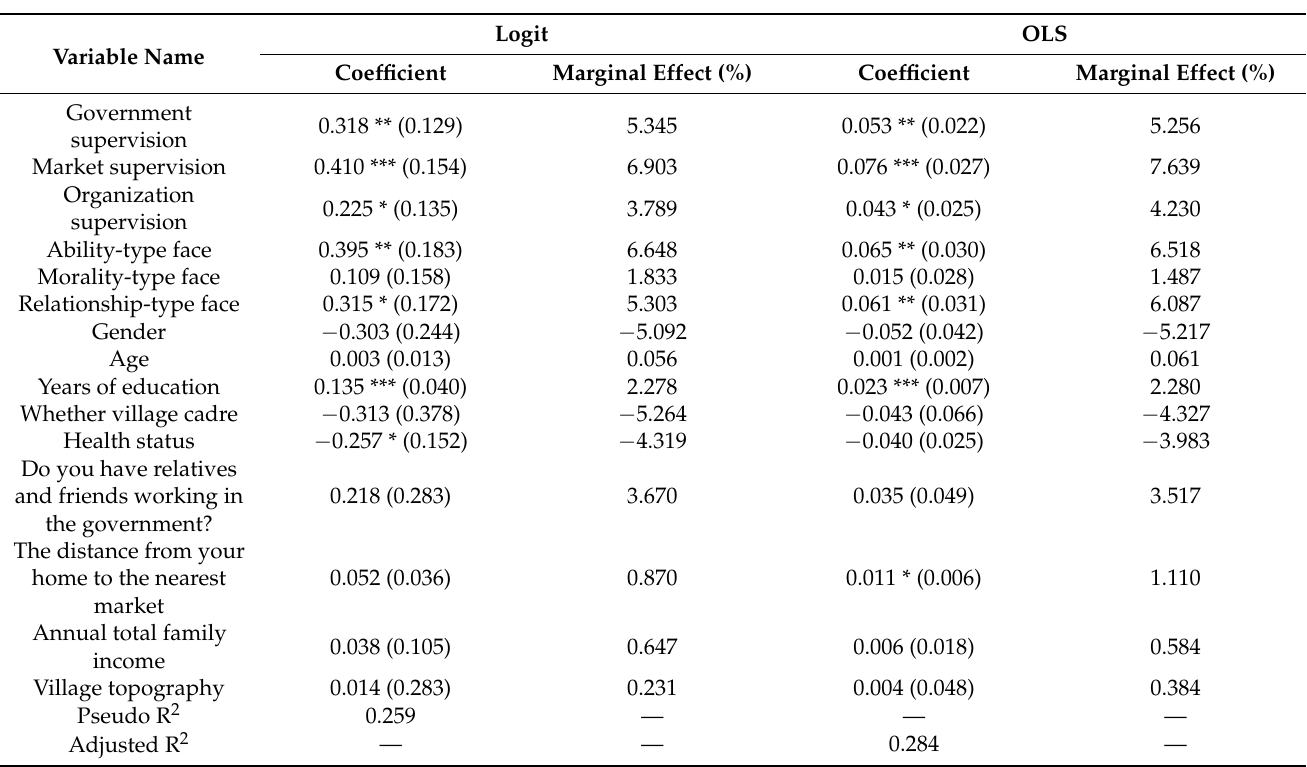
Table 3. Model estimation results of external supervision and face consciousness on farmers’ pesticide safety